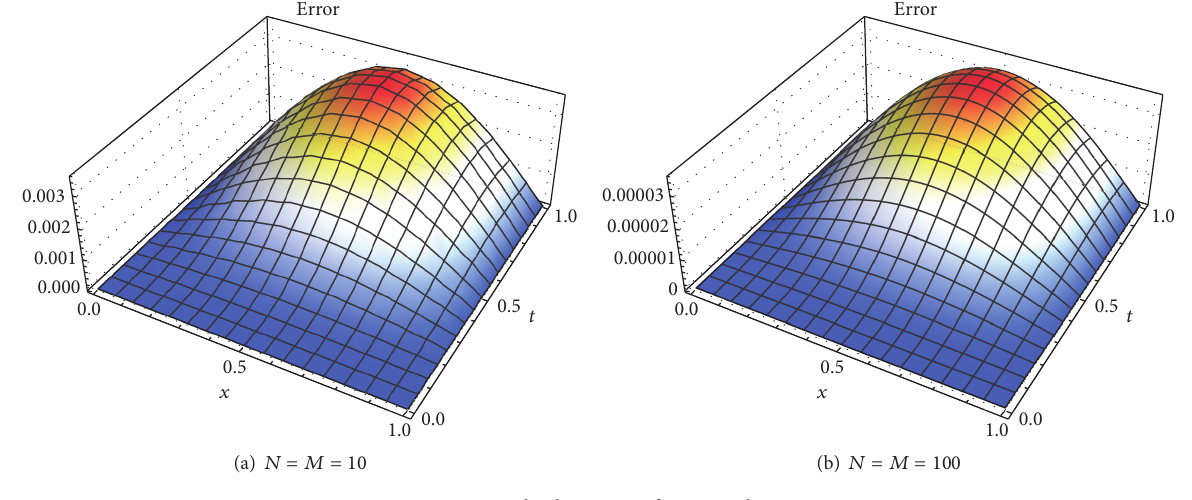
Figure 6: Absolute errors for Example 6.